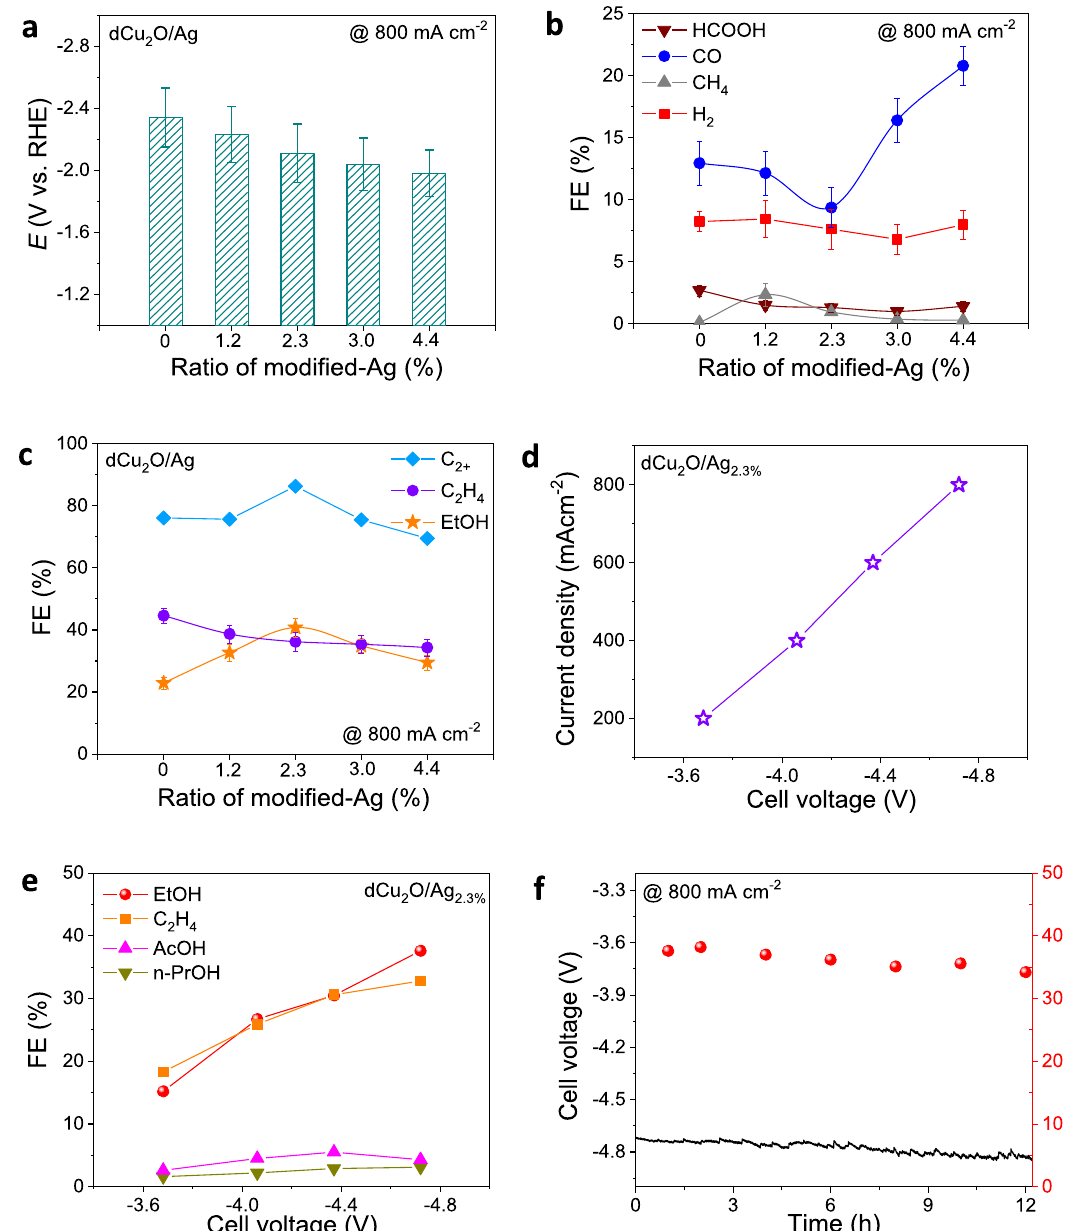
Fig. 4 CO 2 RR performance for dCu 2 O/Ag with modi fi ed Ag. Comparison of a applied potentials, b FEs for C 1 and H 2 product, c FEs for C 2 H 4 and EtOH and total C 2 + product on dCu 2 O/Ag with modi fi ed Ag at current density 800mA cm − 2 . d Total current density and e FEs for C 2 + product for CO 2 RR on dCu 2 O/Ag 2.3% at selected cell voltage under MEA measurement. f Stability test for dCu 2 O/Ag 2.3% at the current density 800 mA cm − 2 in MEA. Error bars correspond to the standard deviation of three independent